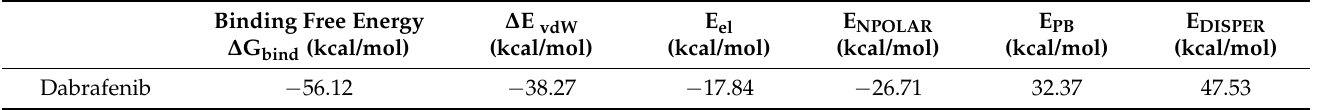
Table 8. MM-PBSA binding energies of Dabrafenib docked at active site of NEK7.